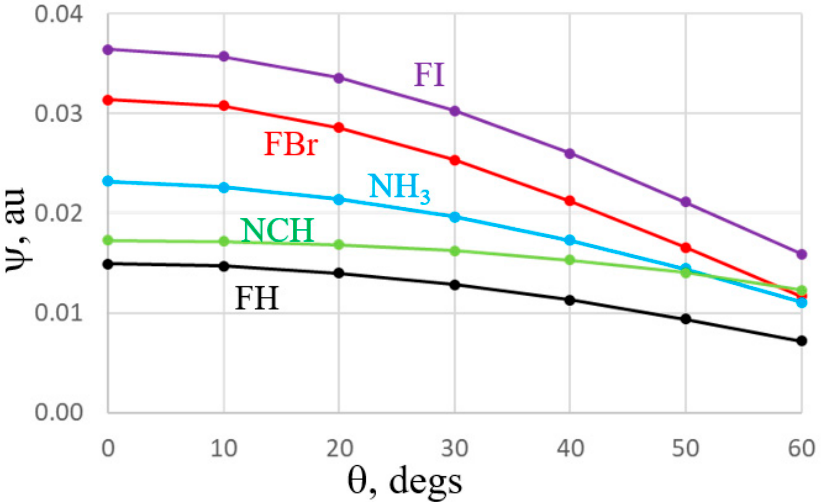
Figure 7. Amplitudes of the σ *(FX) antibonding orbital of FI, FBr, FH, and the N lone pair orbitals of NH 3 and NC, plotted against deviation angle θ from FX axis for acids, NCH axis for NCH, and C 3 symmetry axis of NH 3 . Wave functions were evaluated along a circle centered about the X or N atom, with a radius of 2 Å for all except 1.5 Å for FH.